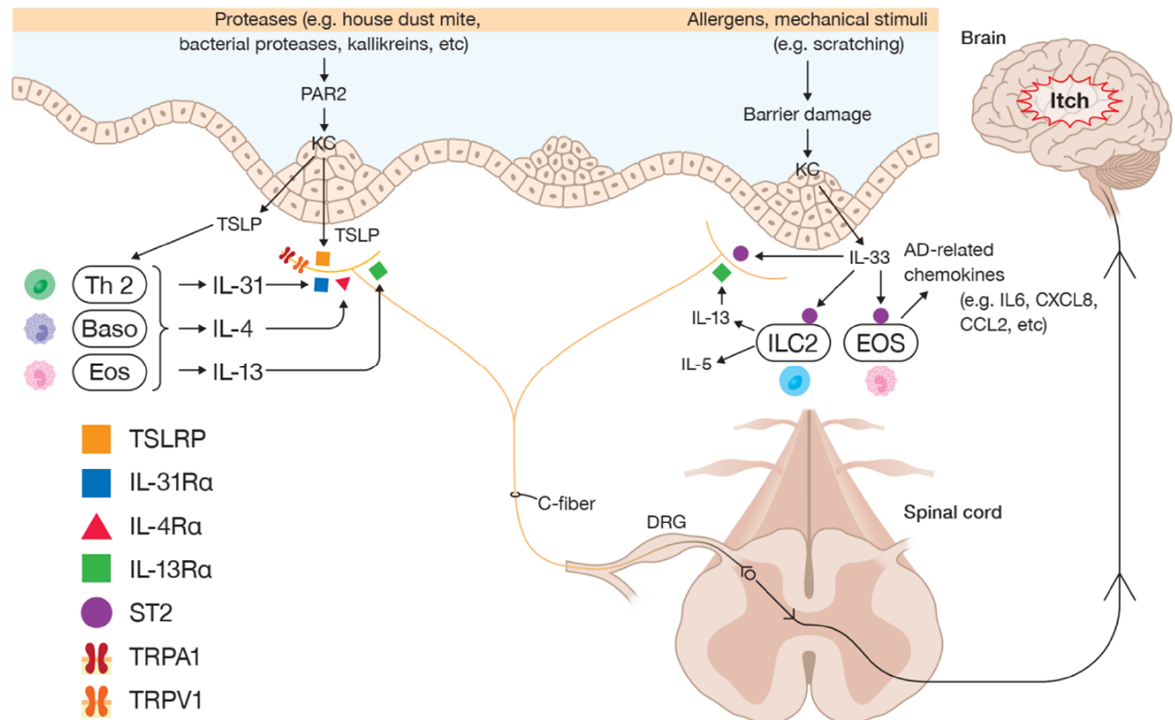
Figure 1. Neuroimmune crosstalk between keratinocytes, primary sensory neurons, and type 2 immune cells in AD skin. Epithelial barrier disruption during exposure to various allergens or triggers, e.g., proteases or scratching, induces keratinocytes to secrete alarmins, such as TSLP and IL-33. TSLP and IL-33 initiate allergic responses by activating ILC2, Th2 cells, and other immune cells, for the production of large amounts of type 2 cytokines, including IL-4, IL-5, IL-13, and IL-31. Alarmins and type 2 cytokines directly activate sensory neurons via their receptors, which signal to the somatosensory cortex in the brain triggering itch or itch sensitization in